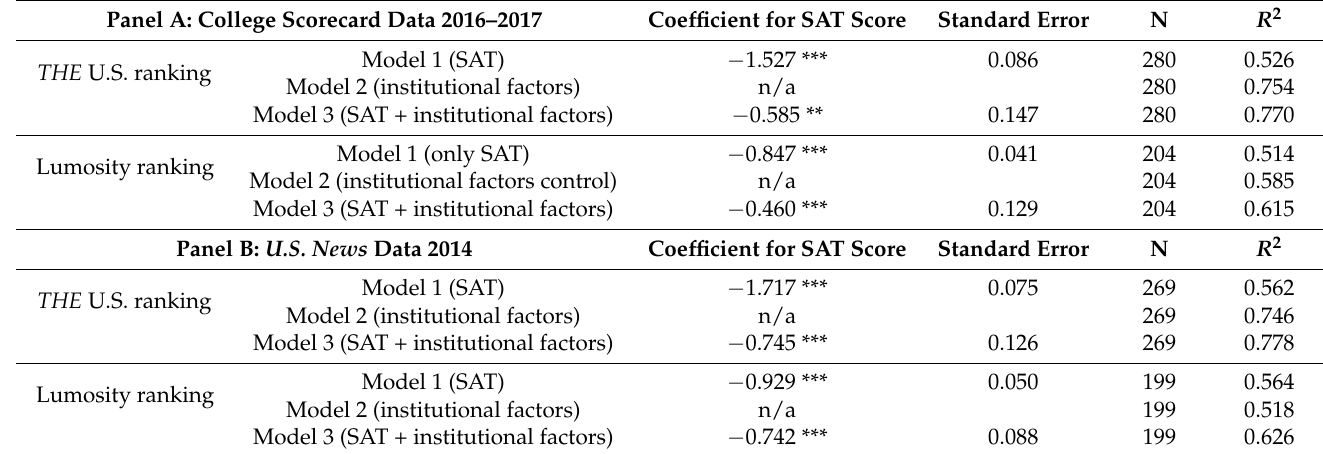
Table 3. OLS coefficients for SAT predicting college and university rankings.